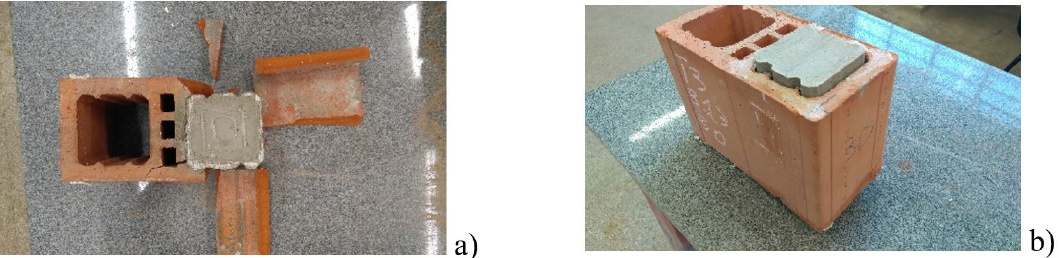
Figure 10. BM4 specimens after push-out test.